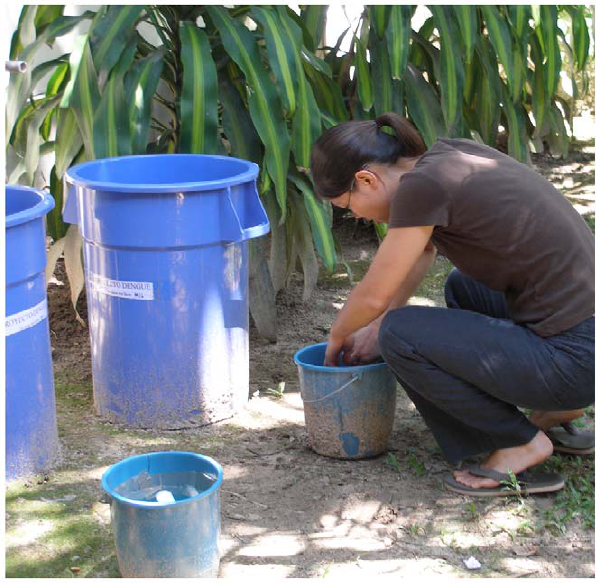
Figure 1. Experimental oviposition containers. Four blue containers made of rigid plastic were set out per house. Two containers were large trash cans (40 cm diameter 6 70 cm height) and two containers were small buckets (21 cm diameter 6 23 cm height). Container size was crossed with fill method (manually filled vs. unmanaged) to create four different